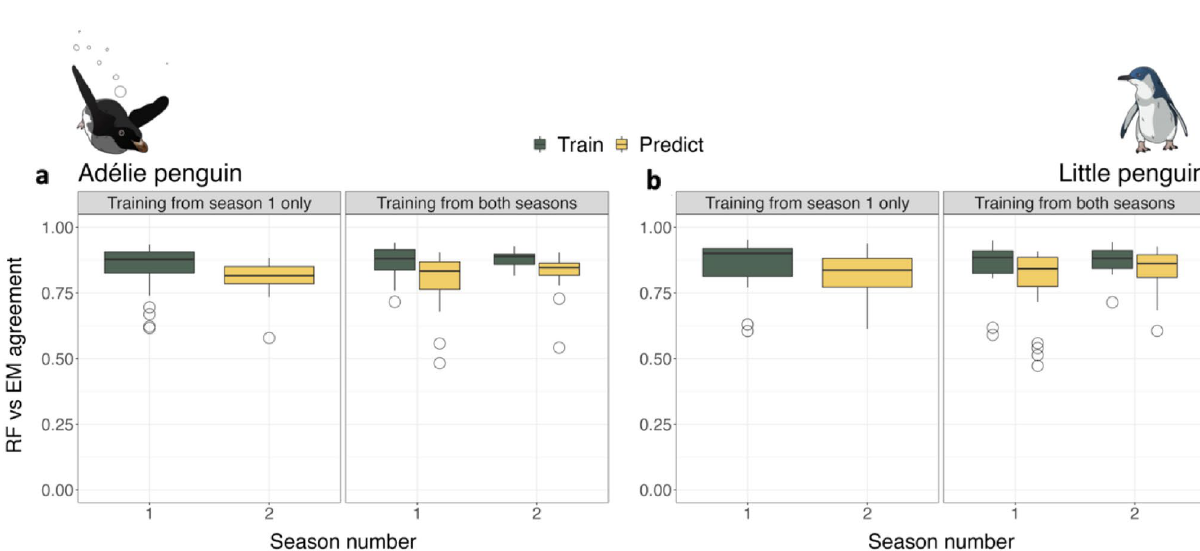
Figure 4. Repeatability scores. Values are calculated for pitch (blue) and VeDBA (yellow) on training datasets obtained from Season 1 (squares) and both seasons (triangles) for both species, Adélie penguin ( Pygoscelis adeliae) ( a ) and little penguin ( Eudyptula minor ) ( b ).